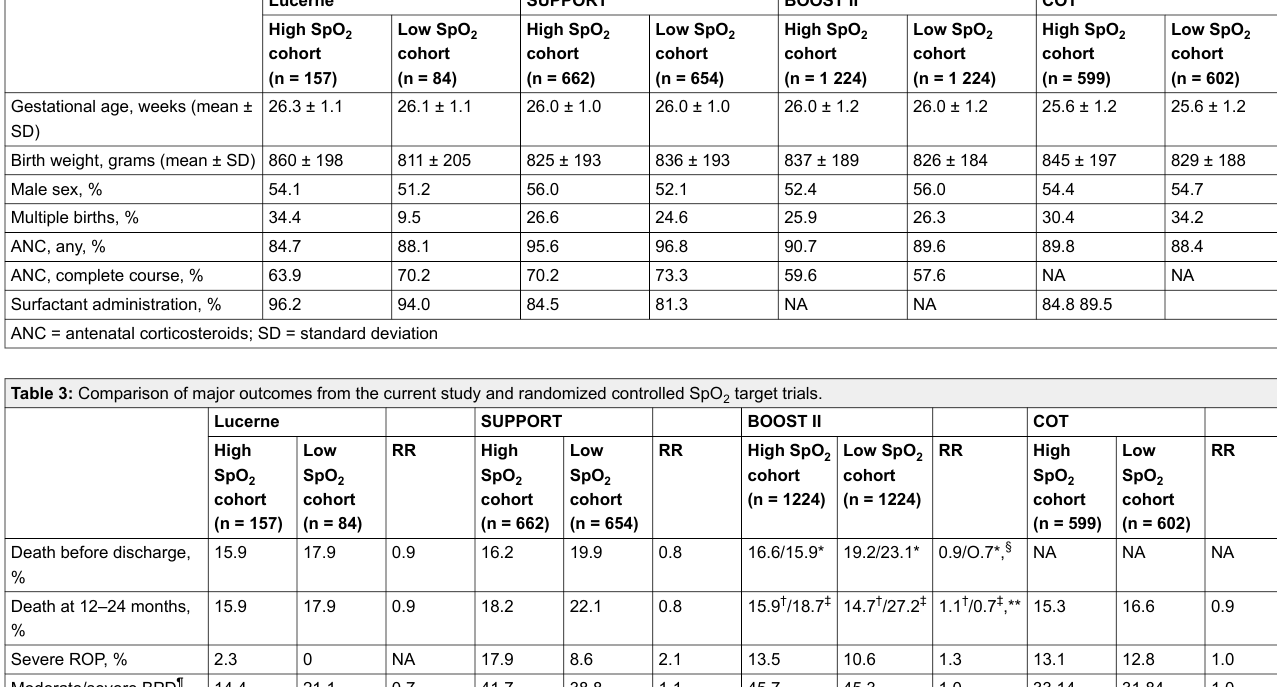
Table 2: Comparison of baseline population characteristics from current study and randomised controlled SpO 2 target trials. Lucerne